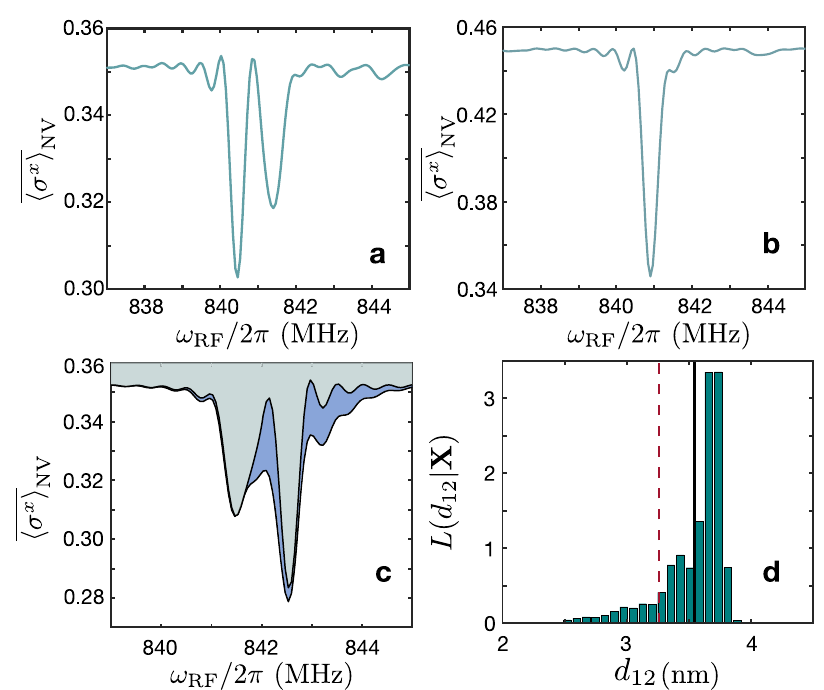
Fig. 3 Simulated spectra and Bayesian inference of the inter-label distance. a Simulated average NV spectrum h σ x i due to g 12 are observed. b Similar to ( a ) but with lower g 12 . c Simulated average spectrum h σ x i 14 N isotopes (blue shaded area) and with distinct 14 N and 15 N isotopes (gray shaded area). d Marginal distribution L ( d distance for simulated data acquisition using the spectrum shown in ( a ). The true value of the distance and its posterior expectation, 3.297 nm and 3.54(25) nm, are indicated with vertical lines. The error is the standard deviation of the marginal